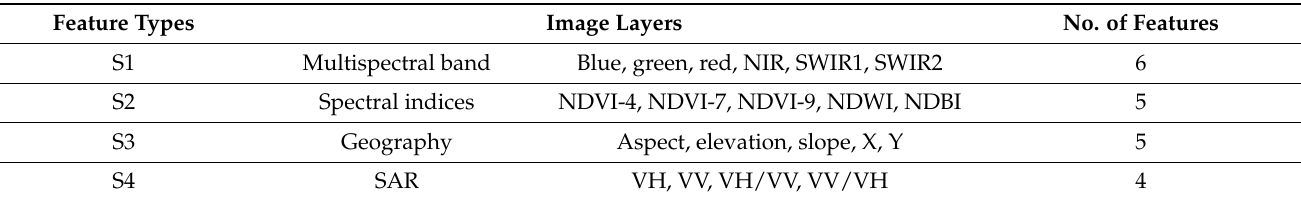
Table 2. Image layers used in pixel-based classifications.